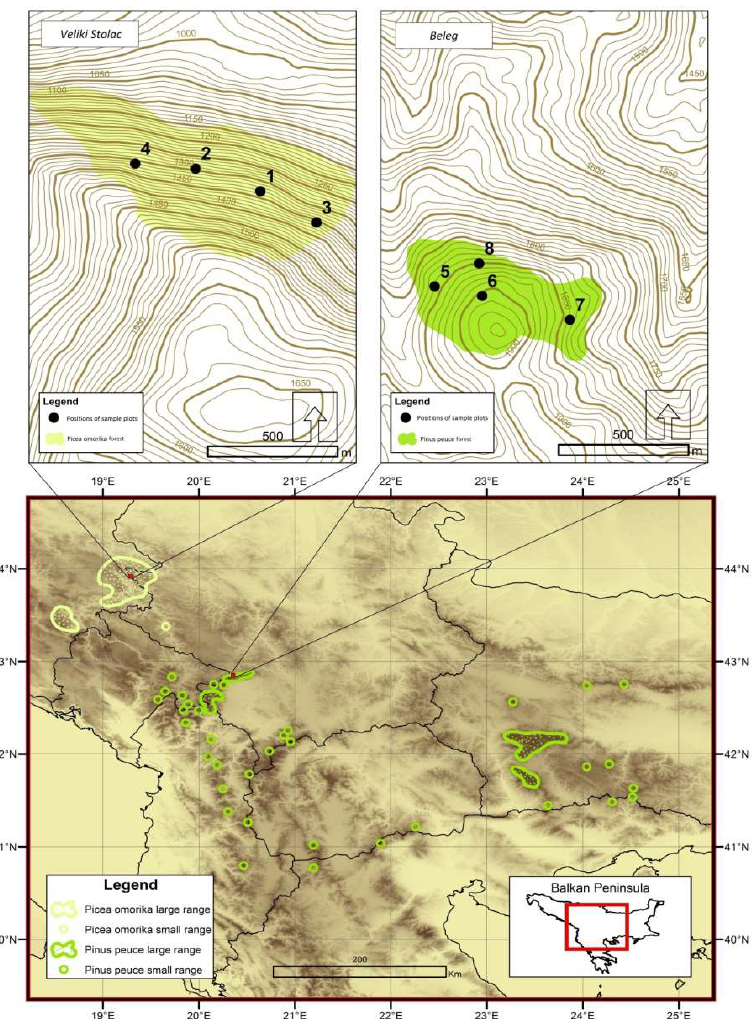
Figure 1. An overview of spatial distribution of the sample plots with the range of the investigated relict-endemic forest communities of the Balkan Peninsula [20]. The sample plots of Serbian spruce are located in the Bosnian municipality of Višegrad ( Veliki Stolac ) and the Macedonian pine in the Serbian municipality of Tutin ( Beleg ).